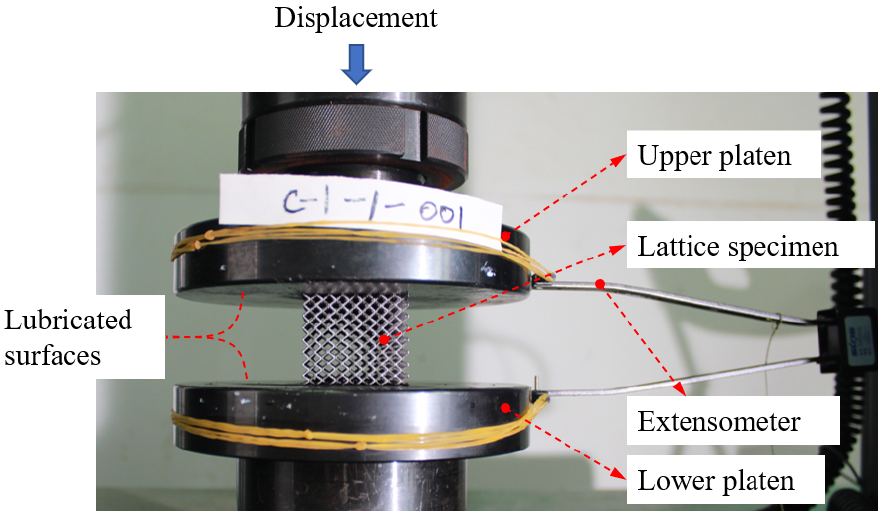
Figure 8. Experimental setup of the quasi-static uniaxial compression tests on the specimens con- structed by BCC and BCC-F lattices at room temperature.